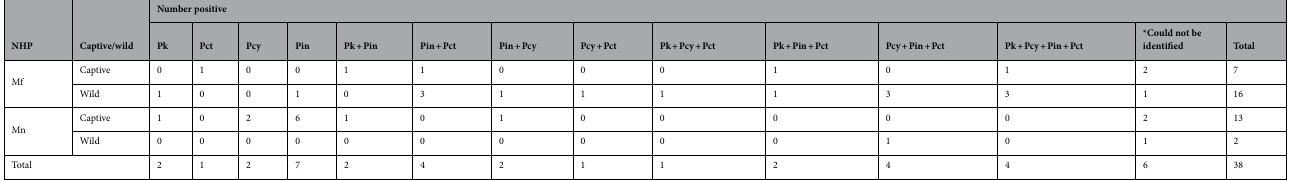
Table 1. Results of species-specific PCR assays for Plasmodium- positive macaques. NHP : Non-human primates, Mf : M. fascicularis , Mn : M. nemestrina , Pk : P. knowlesi , Pct : P. coatneyi , Pcy : P. cynomolgi , Pin : P. inui. *Samples were Plasmodium -positive but species of Plasmodium could not be identified with primers specific for P. knowlesi , P. cynomolgi , P. inui, P. fieldi and P.